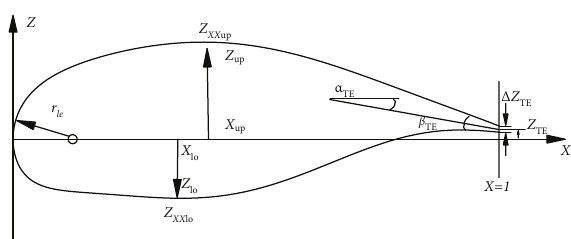
Figure 1: Airfoil parameterization used for numerical optimization